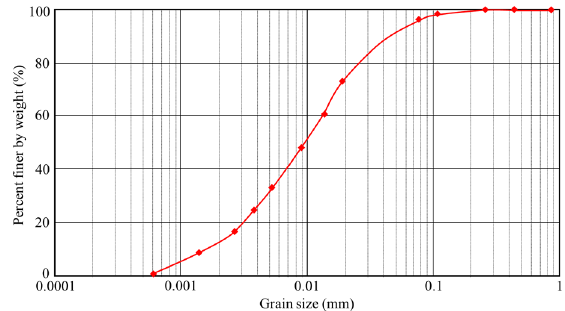
Figure 6. Grain size distribution of the silty clay.